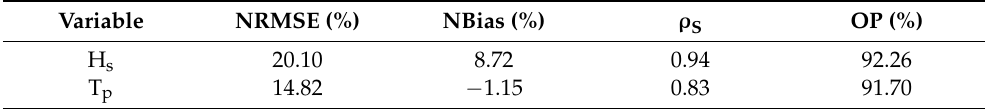
Table 3. Normalized root mean square error (NRMSE), normalized bias error (NBias), Spearman correlation coefficient ( ρ S ), and overlapping percentage (OP) for significant wave height (H s ) and peak period (T p